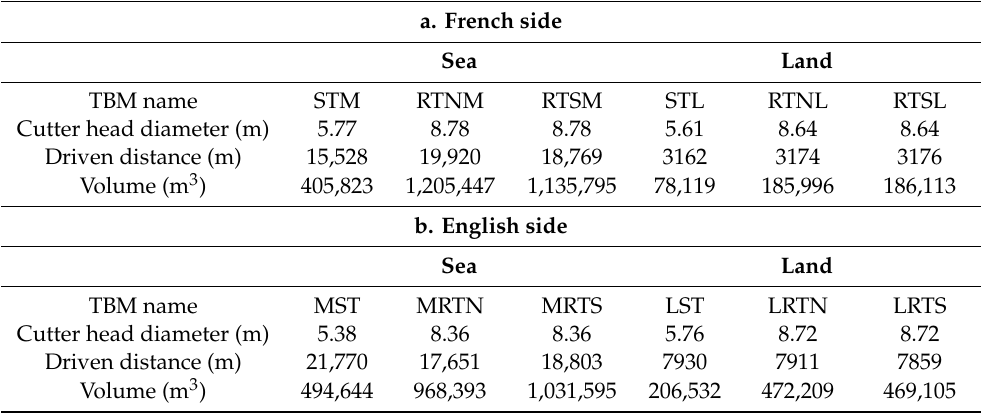
Table 5. Tunnel Boring Machine (TBM) performance for: a. the French side and b. the English side